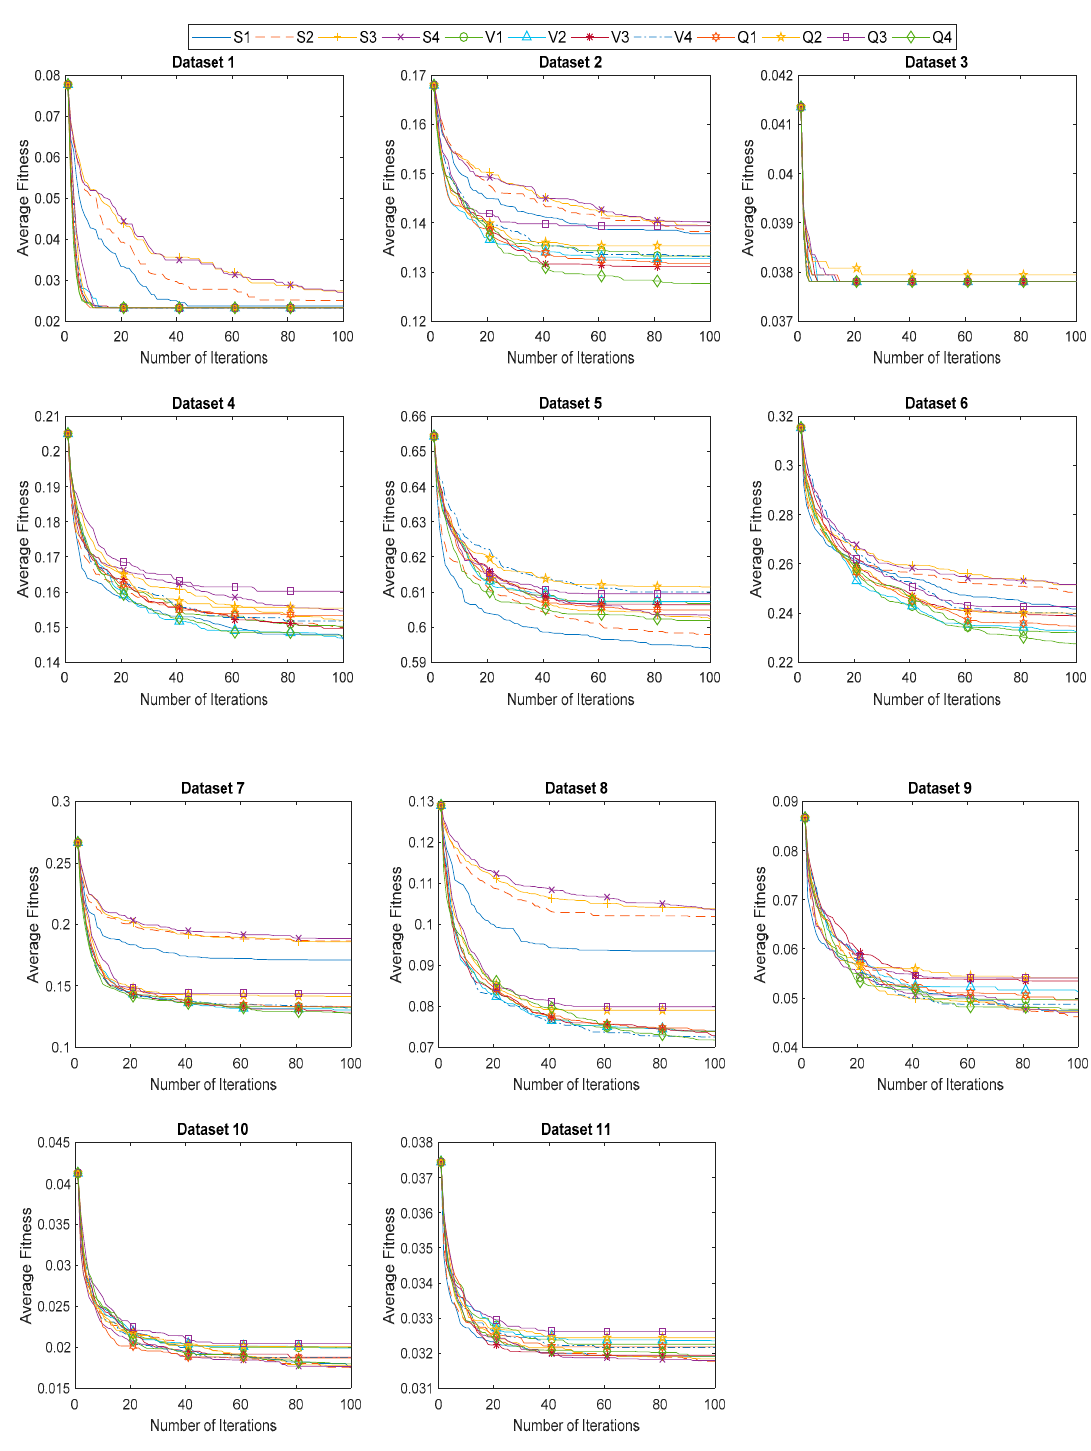
Figure 5. Convergence curves of proposed algorithms on datasets 1–11.